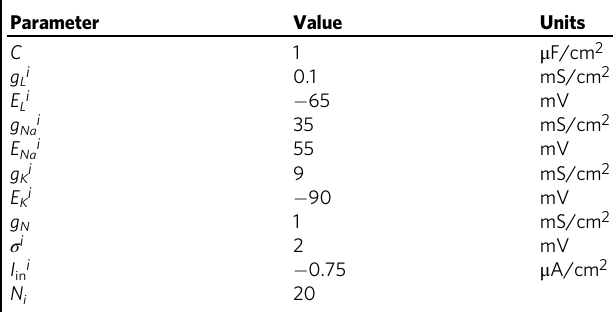
Table 2 Parameters used for modeling I-cells in the conductance-based